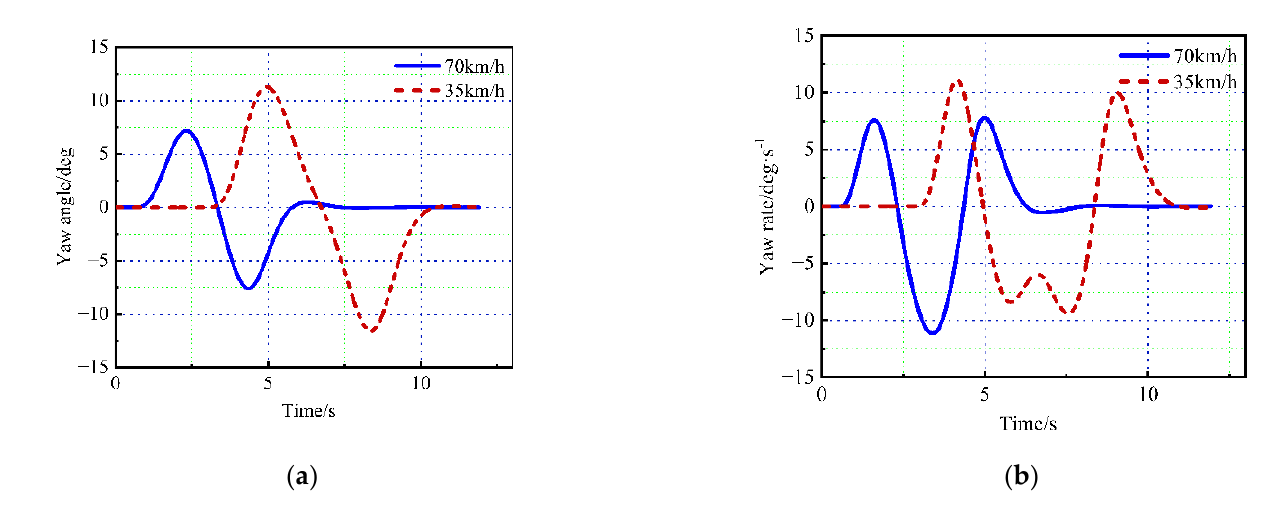
Figure 12. Variation curve of vehicle yaw angle and yaw rate. ( a ) is the yaw angle, ( b ) is the yaw rate.